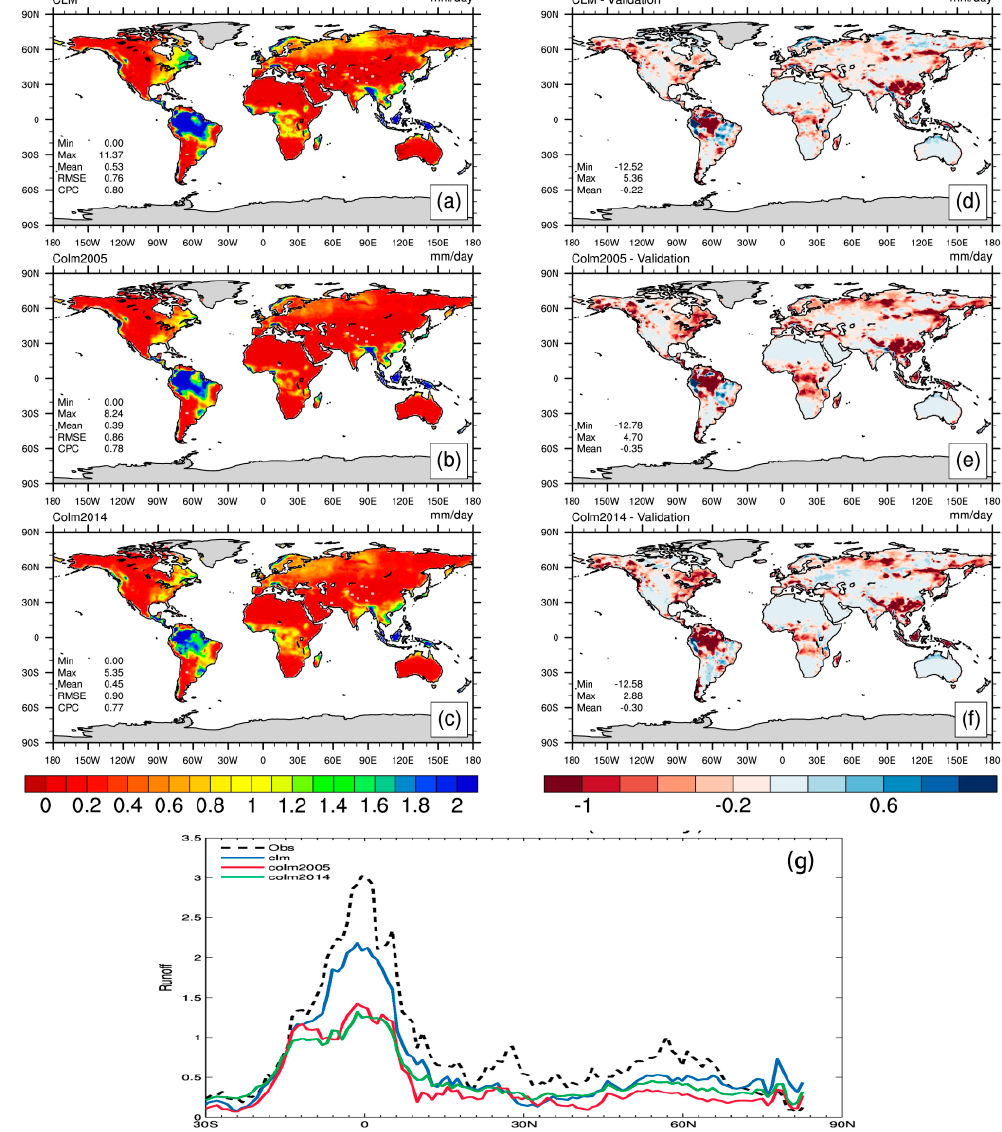
Figure 2. Annual mean spatial distributions of total runoff simulated by ( a ) CLM4.5; ( b ) CoLM2005; and ( c ) CoLM2014; Along with spatial distributions of biases relative to the validation standard for ( d ) CLM4.5; ( e ) CoLM2005; and ( f ) CoLM2014; Panel ( g ) shows zonal mean total runoff from validation observations (black dashed line) and the CLM4.5 (blue), CoLM2005 (red), and CoLM2014 (green) simulations. (Units: mm day − 1 ).